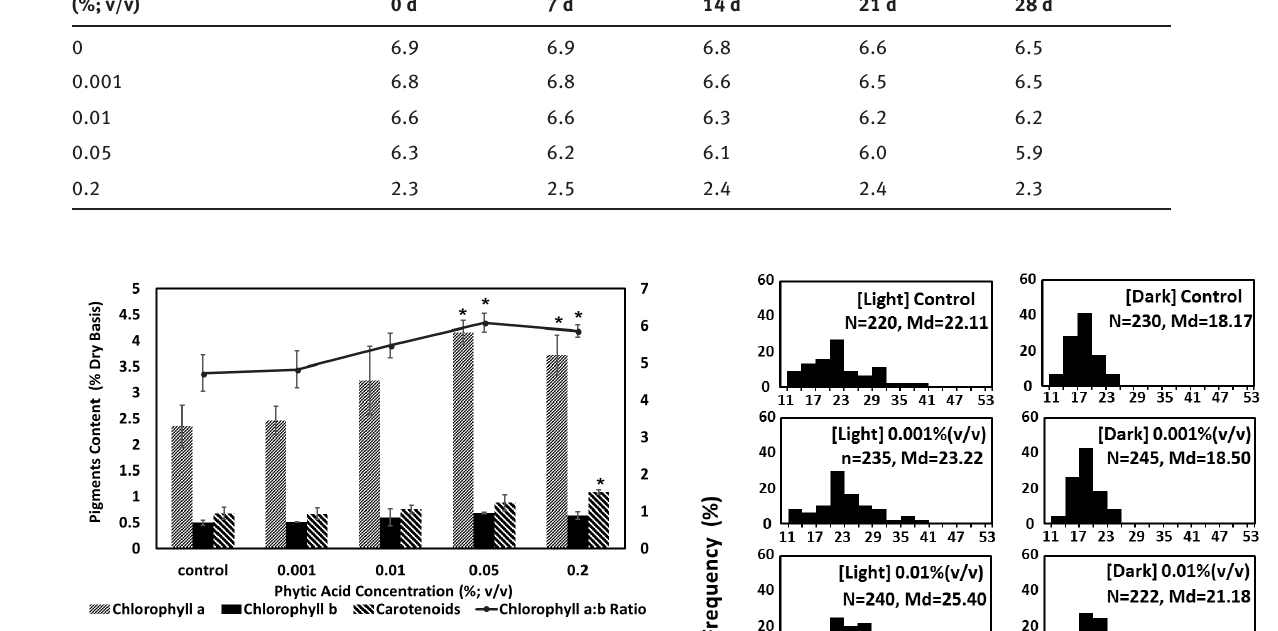
Table 1: Change in pH at different concentrations of phytic acid. Phytic acid concentration pH of the medium during the culture